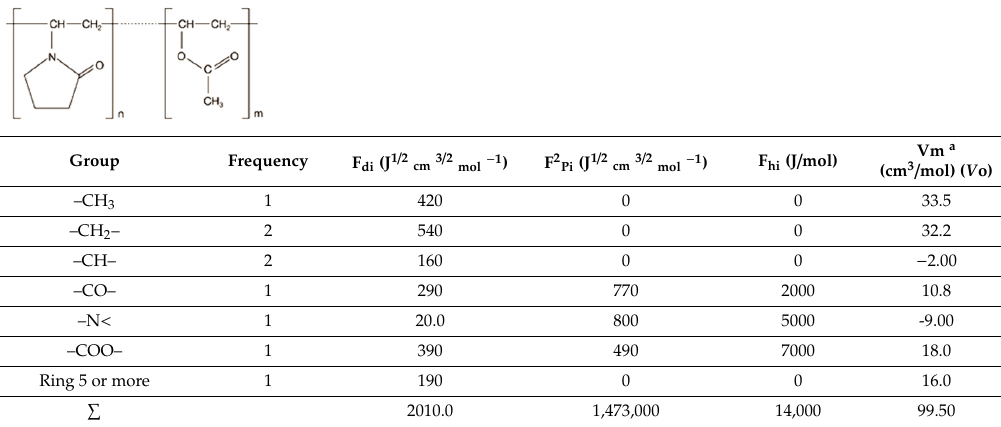
Table 5. Calculation of HSPs and molar volume for P407 according to the Hoftyzer-Van Krevelen method.